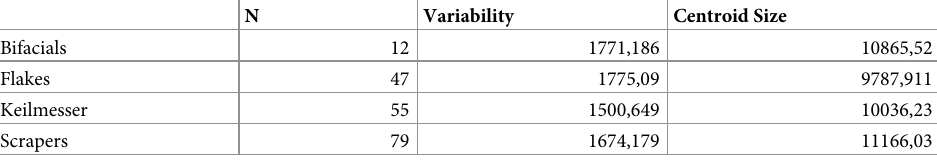
Table 9. 3D statistical analysis on morphological variability and centroid size for tool techno-typological